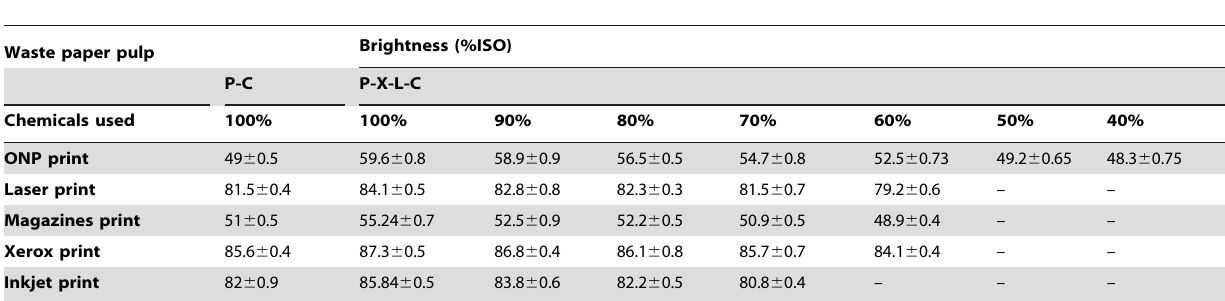
Table 2. Deinking of waste paper pulps by P-X-L-C treatment and reduction in chemical load.